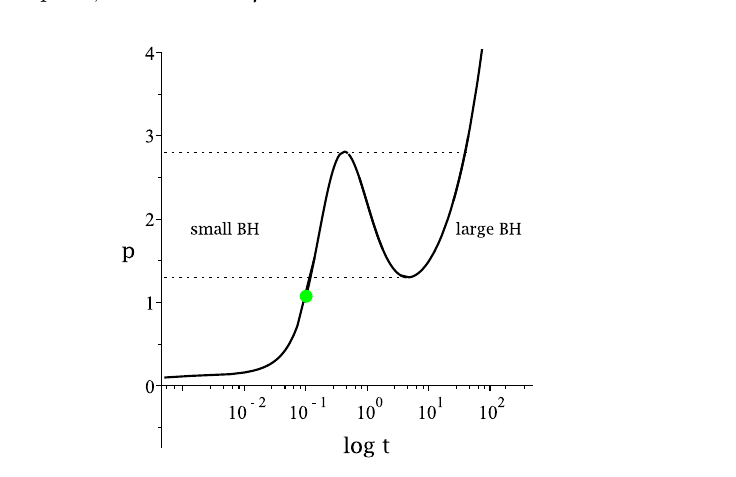
Figure 10 . Isolated critical point for spherical black holes: Left : p vs. t plot for k = +1 with h (cid:25) 1 : 002 h (cid:14) =1 ;(cid:15) =1 . Right : p vs. t plot for k = +1 with h = h (cid:14) =1 ;(cid:15) =1 . As h is adjusted to the value h (cid:14) =1 ;(cid:15) =1 the two critical points (red dots) move together, merging for this particular value of h (green dot). In both plots, (cid:11) = (cid:0) 5 and q = 4.